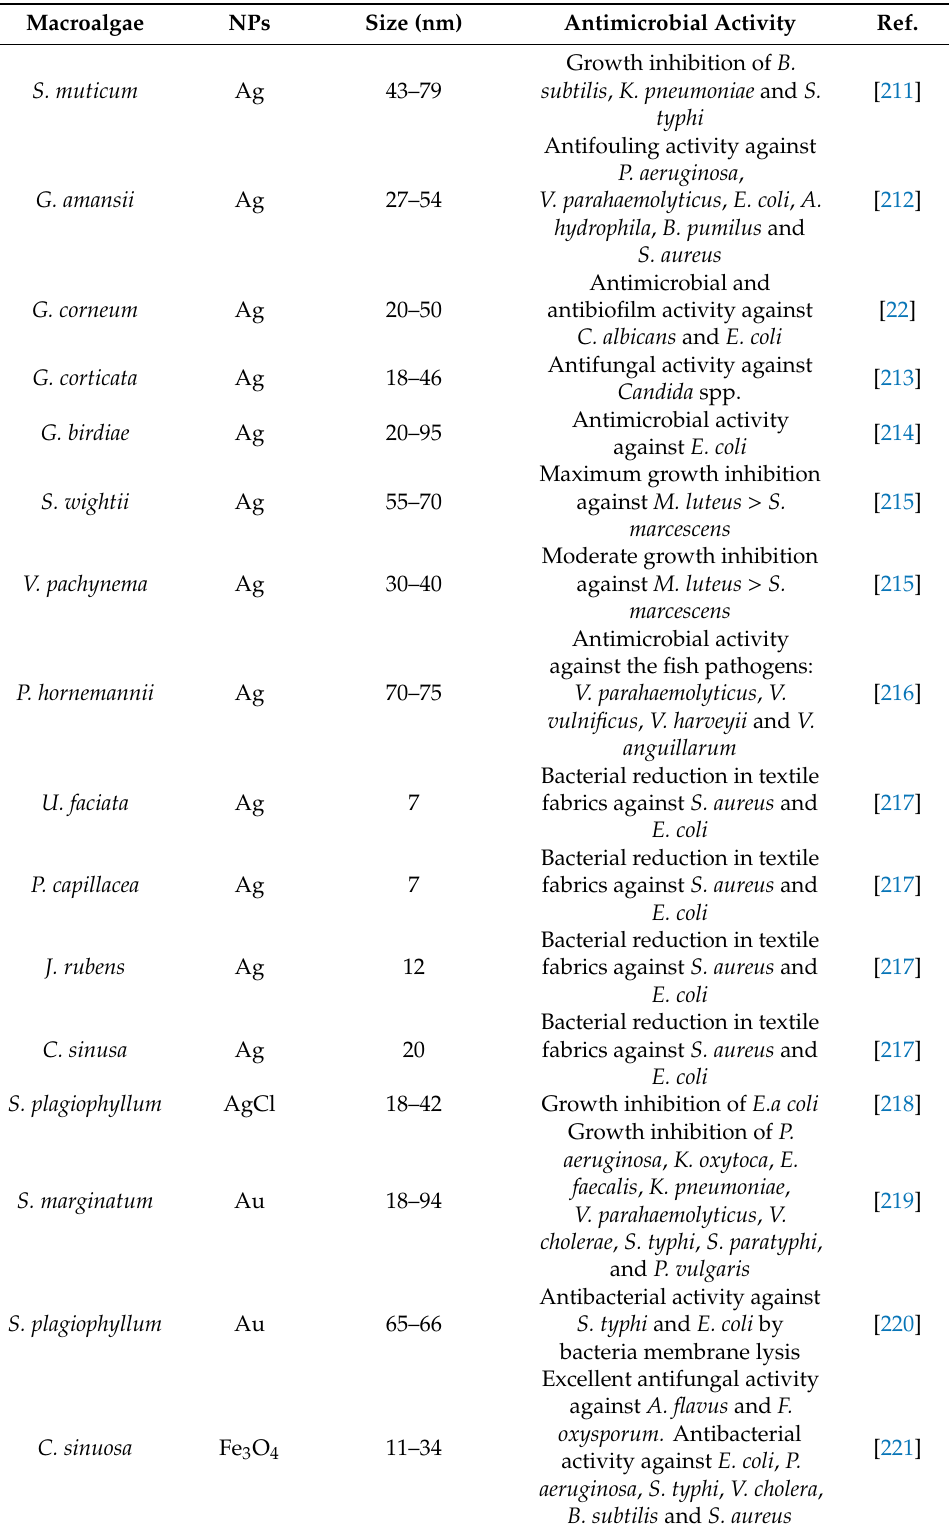
Table 4. Macroalgae-based nanoparticles (NPs) with antimicrobial properties.